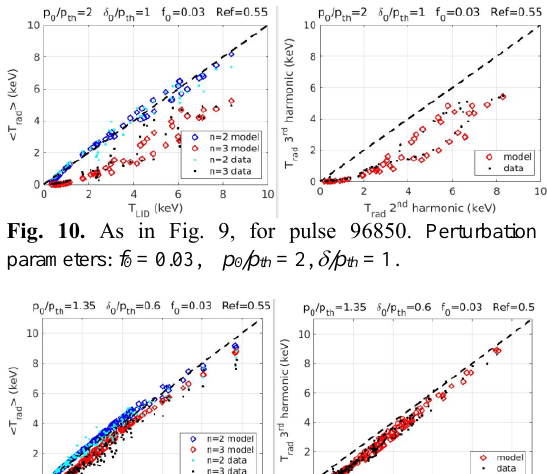
- Fig. 7: DD baseline discharges with low gas, low Neon injection and pellets, characterised by small ELMs and partially detached divertor [14]. - Fig. 8: DT discharges in the baseline scenario. - Fig. 9: DT discharges in the hybrid scenario.